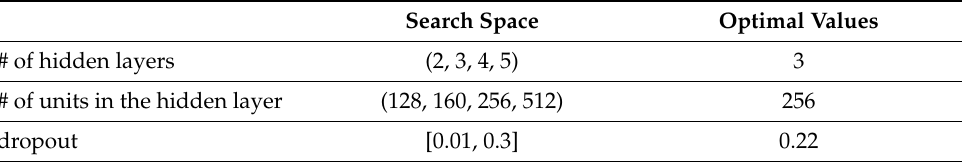
Table 4. Search spaces and optimal values of the model structure hyperparameters.